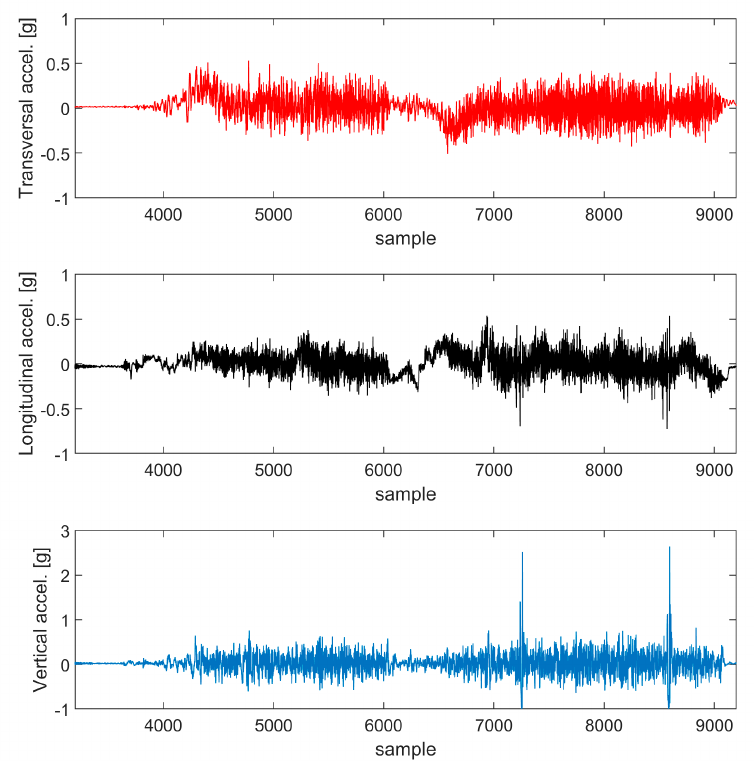
Figure 2. Changes in acceleration components during the home delivery stage. Registration: Matlab Mobile for Android on Huawei Mediapad M3, sampling rate 100 Hz, accelerometers work in ±30 m/s 2 (3 g) acceleration range, 8 bit resolution. Samples below 4000, exit from the national road; 4000 to 6000, side road with cobbled surface; over 6000, driving on a cobbled street with slowing down thresholds type “sleeping policeman”. Driving speed below 30 km/h, distance of the trip: 250